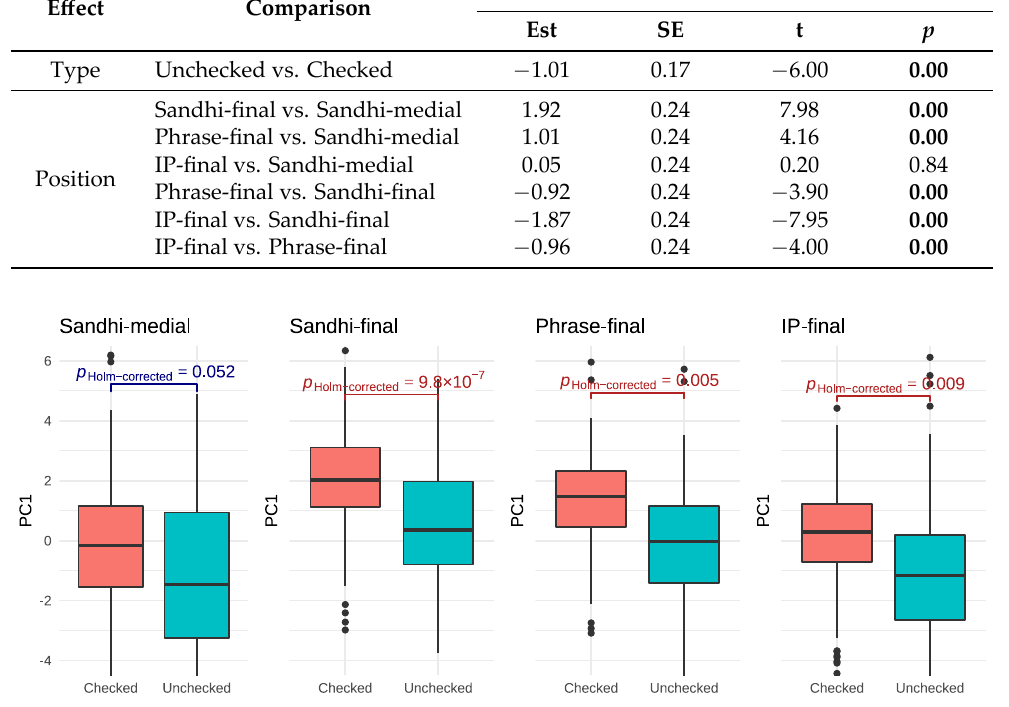
Figure 4. The variation of PC1 influenced by phonemic type and prosodic position. Greater PC1 in‑ dicates a more constricted glottis. Significant p ‑values ( p ⩽ 0.05 ) are marked in red, which indicates that the PC1 difference between checked and unchecked syllables is significant in that prosodic po‑ sition.